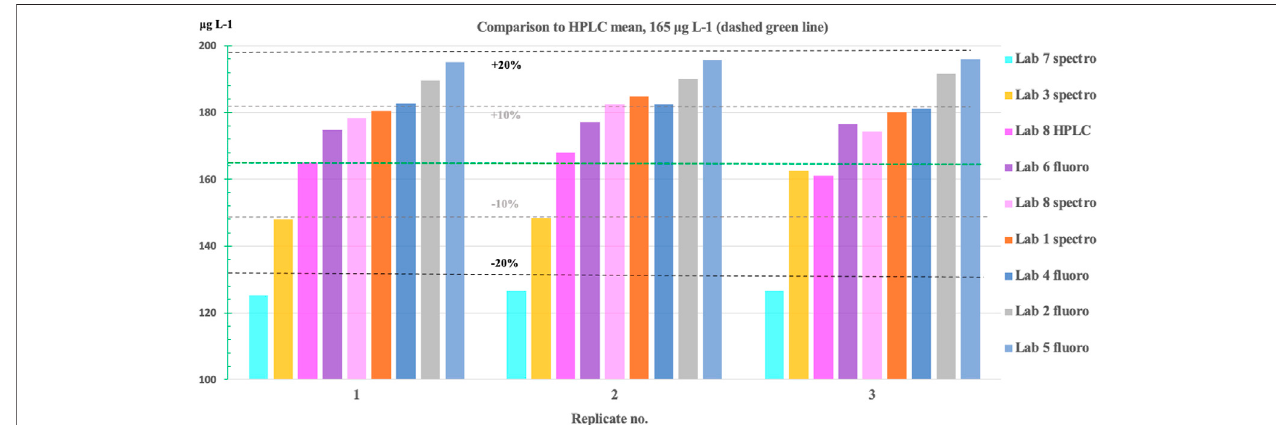
FIGURE 5 | Results for the Chl-a standard concentrations measured by the different laboratories. The mean concentration of the HPLC measurements (Lab 8) is indicated by the dashed green line. The measurements of the Baltic Sea monitoring laboratories are within about − 7% to +19% error (±2 – 3%). Note that Lab 7 uses